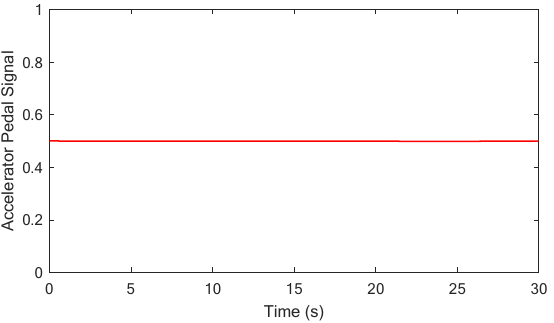
Figure 17. Acceleration pedal at the sinusoidal line shift condition.